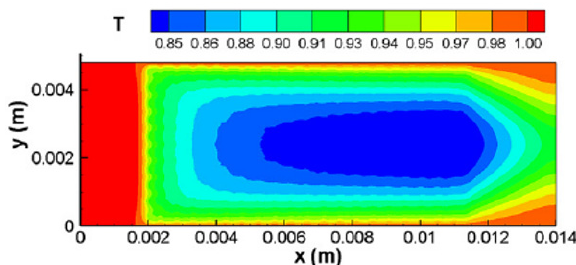
Figure 7. Contours of normalized temperature (T/T inlet ) [20].